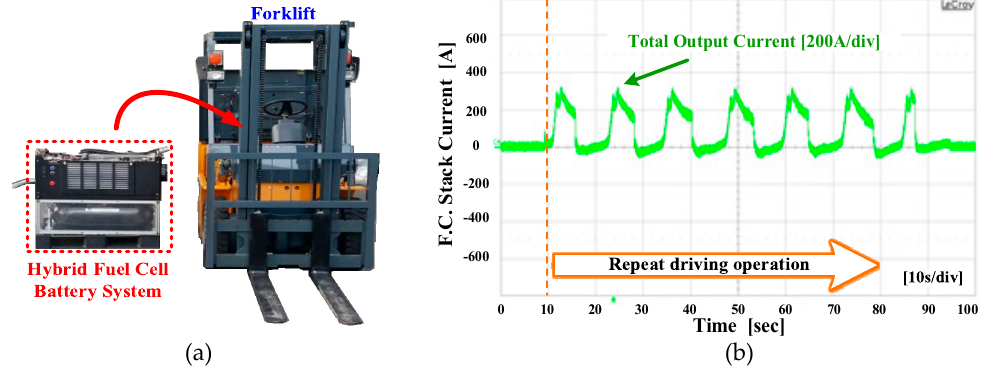
Figure 17. ( a ) The forklift with hybrid fuel cell battery system and ( b ) the total output current of the hybrid fuel cell battery system during forklift operation.